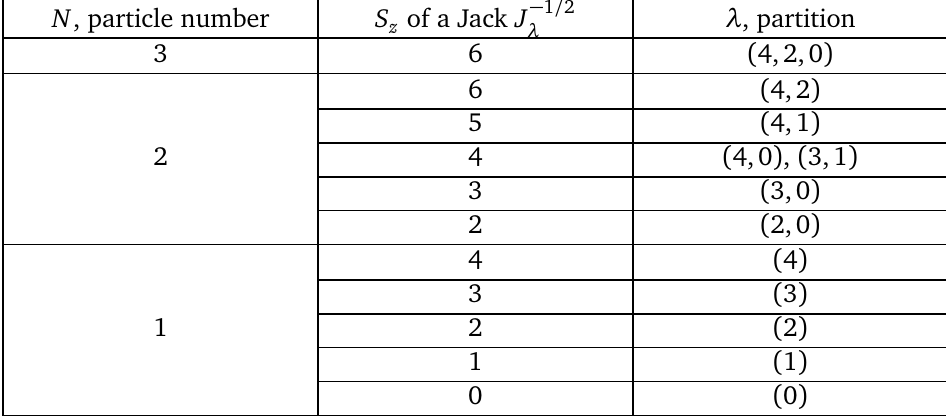
, see Eq. (54). Wave- z